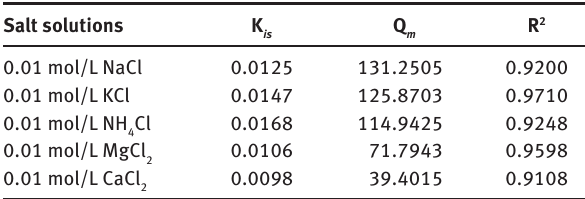
Table 4: Swelling kinetic parameters of SC-g-PAA/PAM/Urea